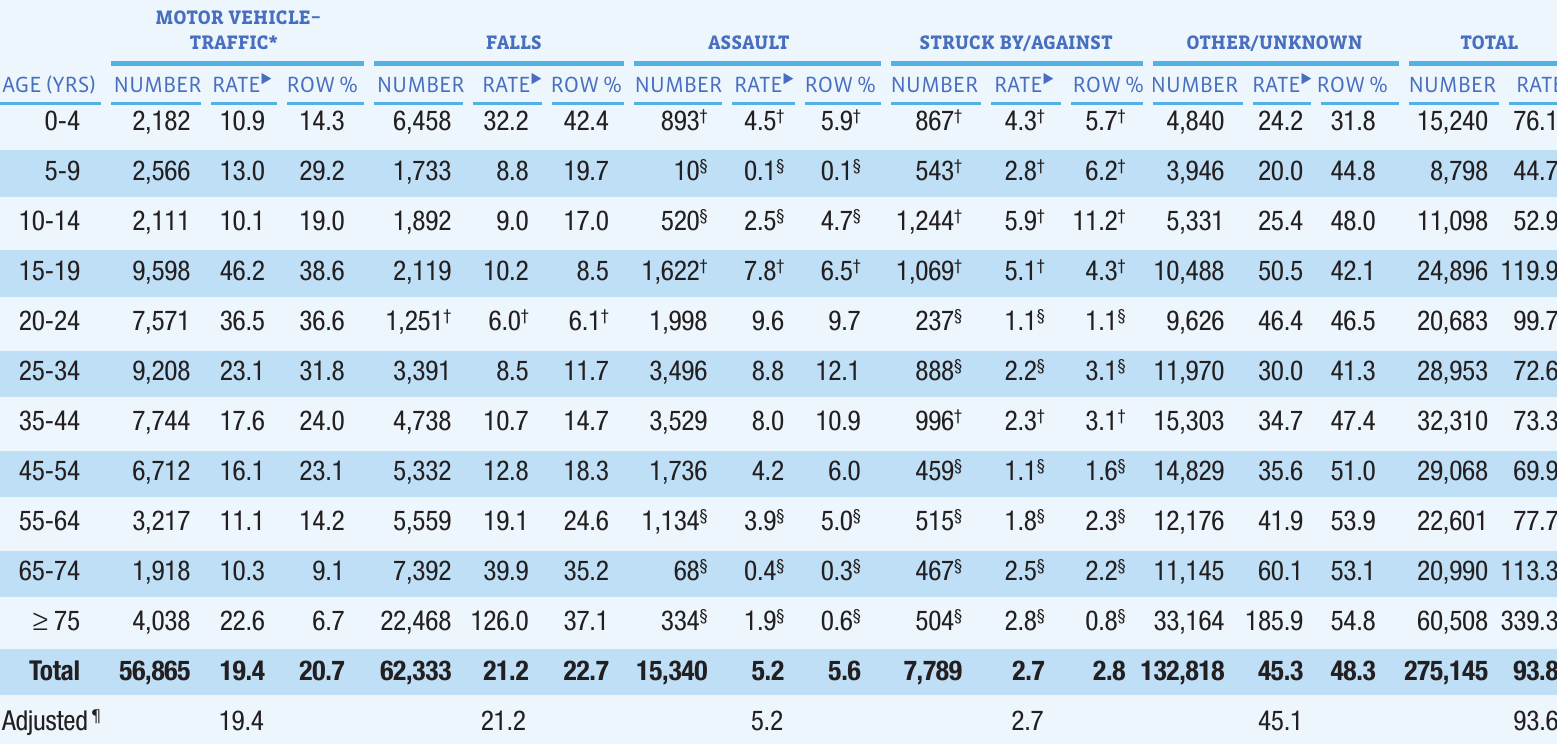
TABLE 11: Estimated Average Annual Numbers, Rates, and Percentages of Traumatic Brain Injury- Related Hospitalizations, by Age Group and External Cause, United States, moTor VeHIcle– TrAFFIc* FAlls AssAulT sTruck By/AgAInsT oTHer/unknoWn ToTAl